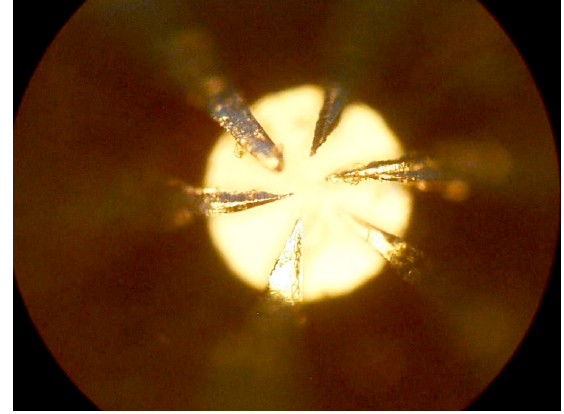
Figure 2. Diamond anvil cell’s culet (300 μ m diameter) with 6 Pt contacts.